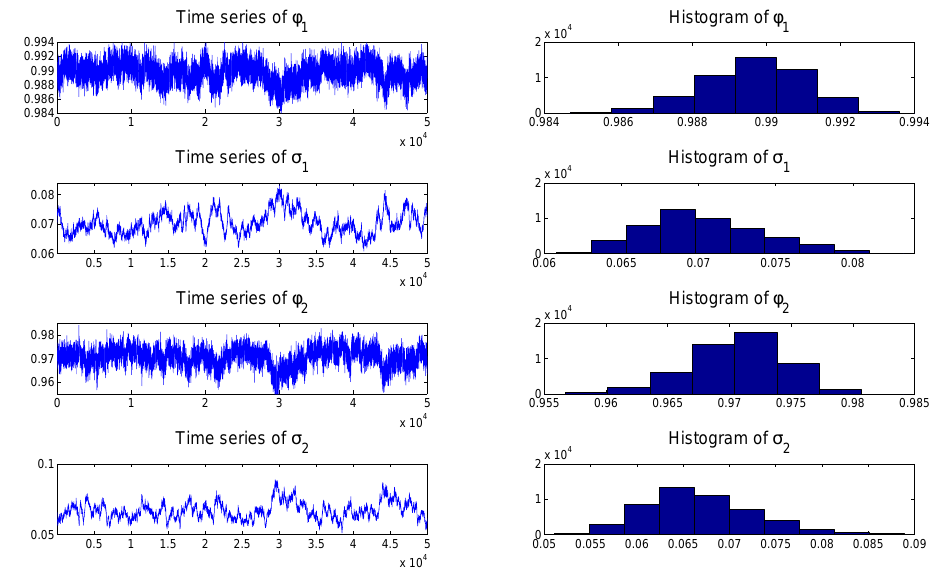
Figure 7. Time series and histograms of the samples drawn from the full conditionals of the parameters in the AR(1) process of the double TSCD-W model based on the Boeing stock duration data.